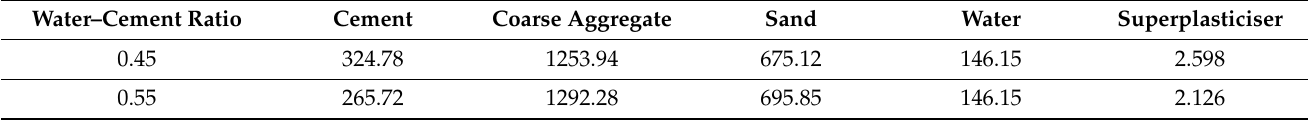
Table 1. Mix proportion of concretes investigated in this study (kg/m 3 ).